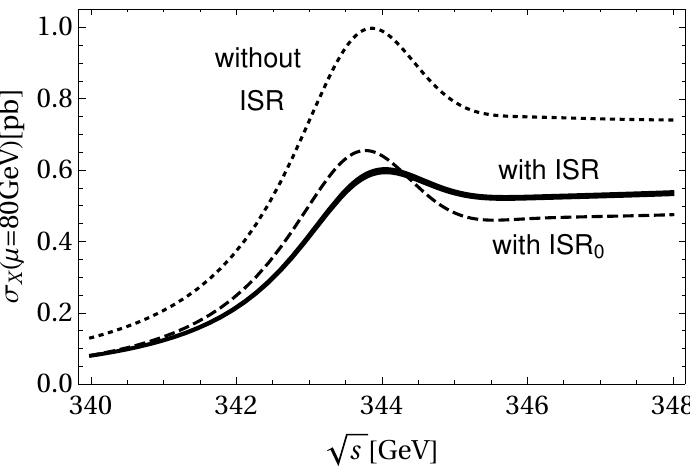
Figure 15 . The e(cid:11)ect of initial-state QED radiation on the cross section. The dotted curve shows the full result without ISR. The solid band (with ISR) is the envelope of results obtained by convoluting the full ‘partonic’ cross section with the structure functions with di(cid:11)erent systematics (see text). The dashed line (with ISR 0 ) is obtained by convoluting only the leading order ‘partonic’ cross section with the structure functions and adding the full ‘partonic’ corrections on